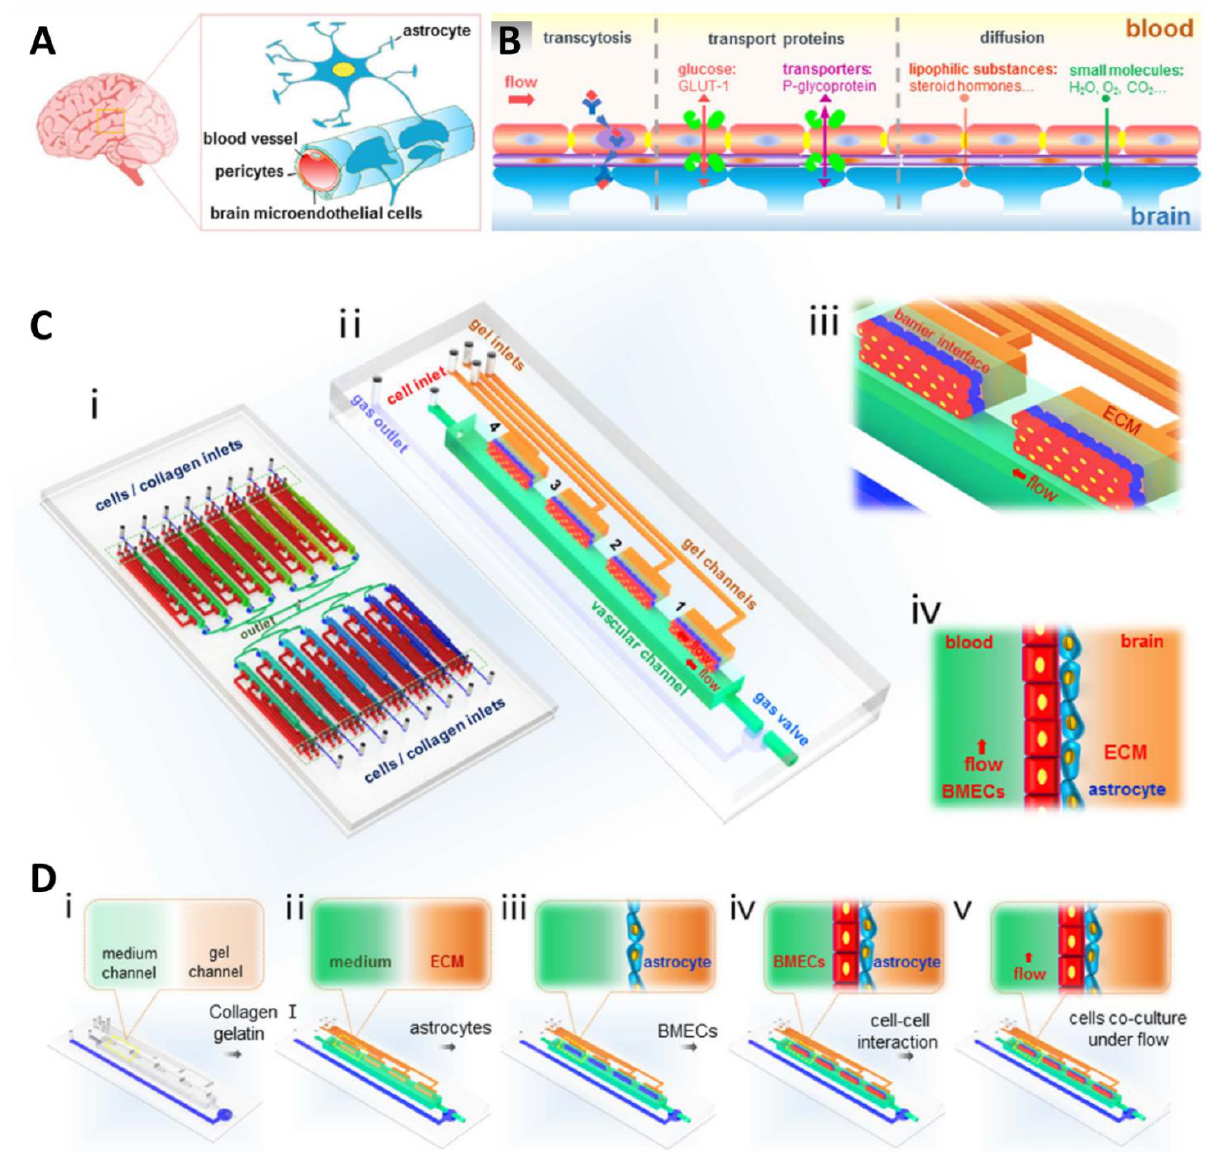
Figure 7. ( A ) Cellular constituents of the BBB in vivo. ( B ) Schematic illustration of BBB function with the expression of several transporters and functional proteins. ( C ) The design and structure of the integrated BBB device: ( i ) device design composed of 16 independent function units connected by a microchannel network ( ii ) consisting of four uniform BBB regions; ( iii ) enlarged view, and ( iv ) side-view of the barrier regions. ( D ) Illustration of the procedures to establish the BBB under flow with the following steps: ( i ) The empty device with closed gas valve and vascular channels; ( ii ) infusion of collagen, gelatin, and cell medium with gas valve opened; ( iii ) suspension of ACs perfused into the vascular channel and attachment to the side surface of ECM; ( iv ) suspension of BMECs perfused into the vascular channel and attached to the ACs; ( v ) co-cultures of BMECs and ACs in the vascular channels under continuous flow [144].